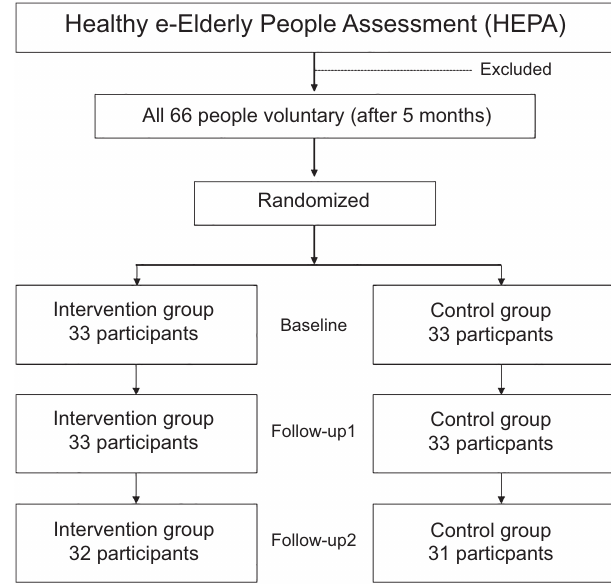
Figure 2. Flow diagram